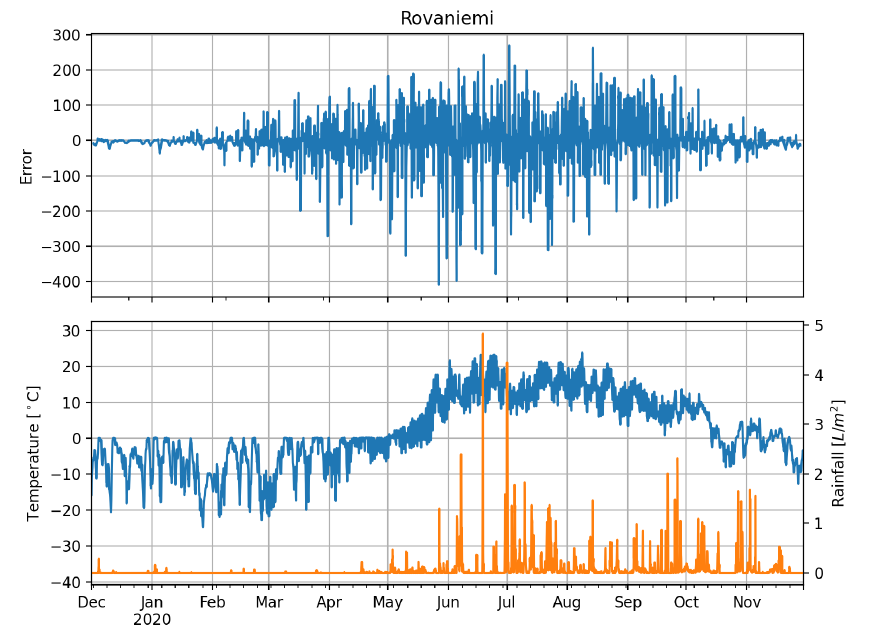
Figure 15. Error of LSTMconv Model and temperature/rainfall in Rovaniemi from 1 December